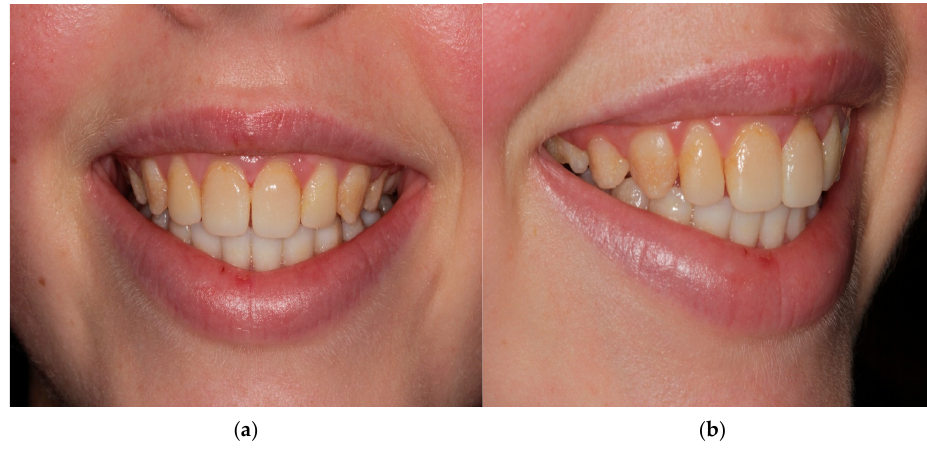
Figure 1. ( a , b ): Case 1—preoperative smile photographs.